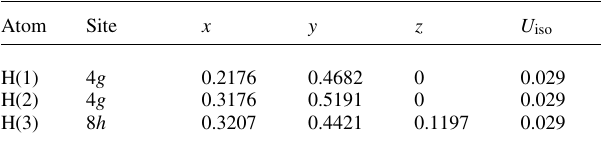
Table 2. Atomic coordinates and displacement parameters (in Å 2 )